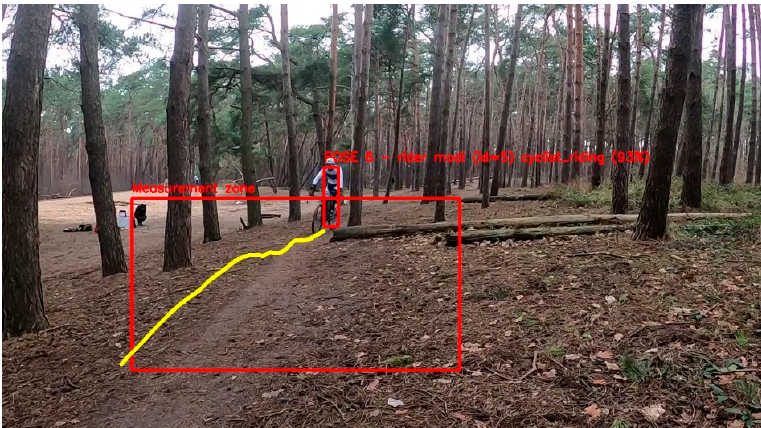
Figure 2. Illustration of the fence principle on a video frame of a cyclocross training session. The red rectangle is the region of interest. Results of pose detection, tracking, and post processing are illustrated by the yellow path within the fence.